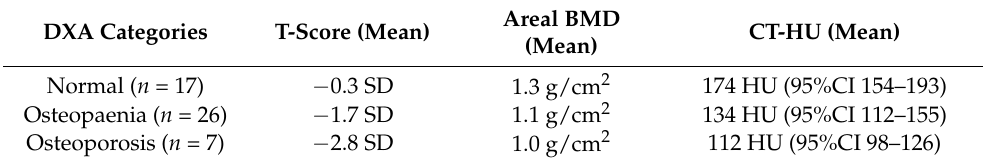
Table 2. Mean T-score, mean areal BMD, and mean CT-HU for women in each DXA derived diagnostic